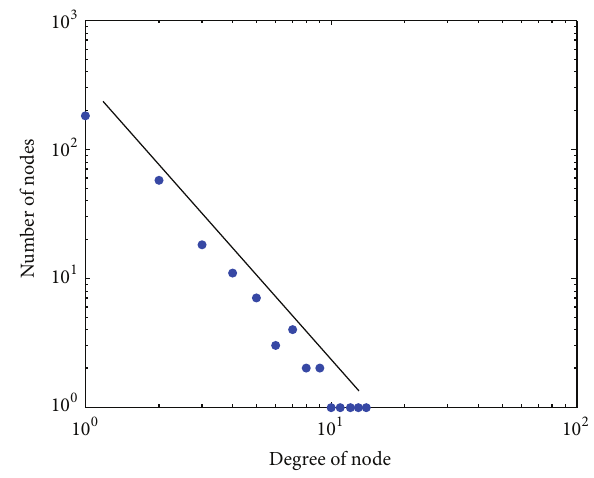
Figure 3: Scale-free feature of